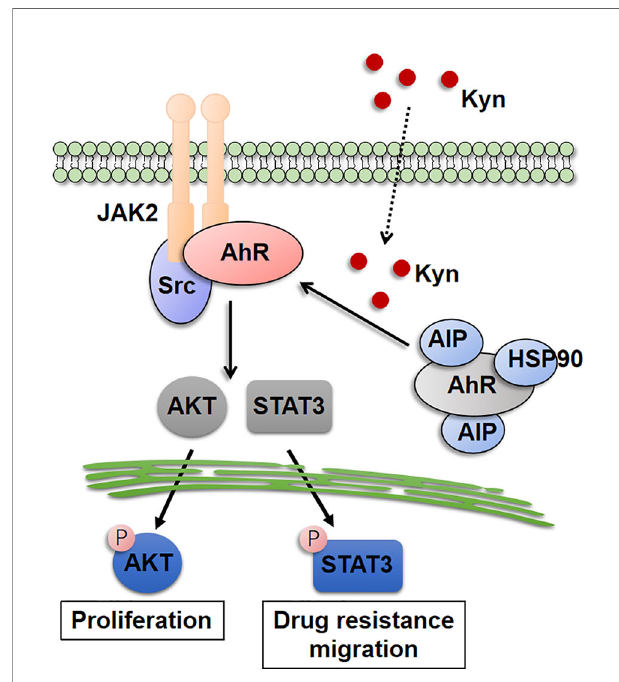
FIGURE 6 | The schematic diatgram of CAFs induced renal cancer